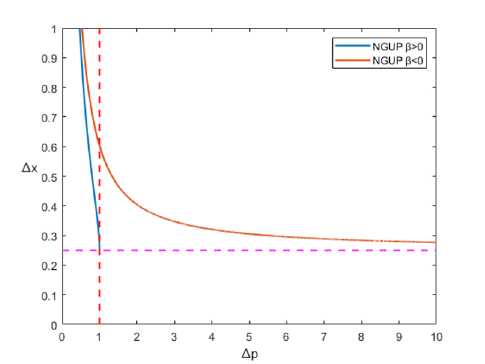
Figure 4 . The ∆ x as the functions on ∆ p given by NGUP for β > 0 and β < 0 . The red and pink dotted lines respectively represent the positions of the maximum momentum and the minimum